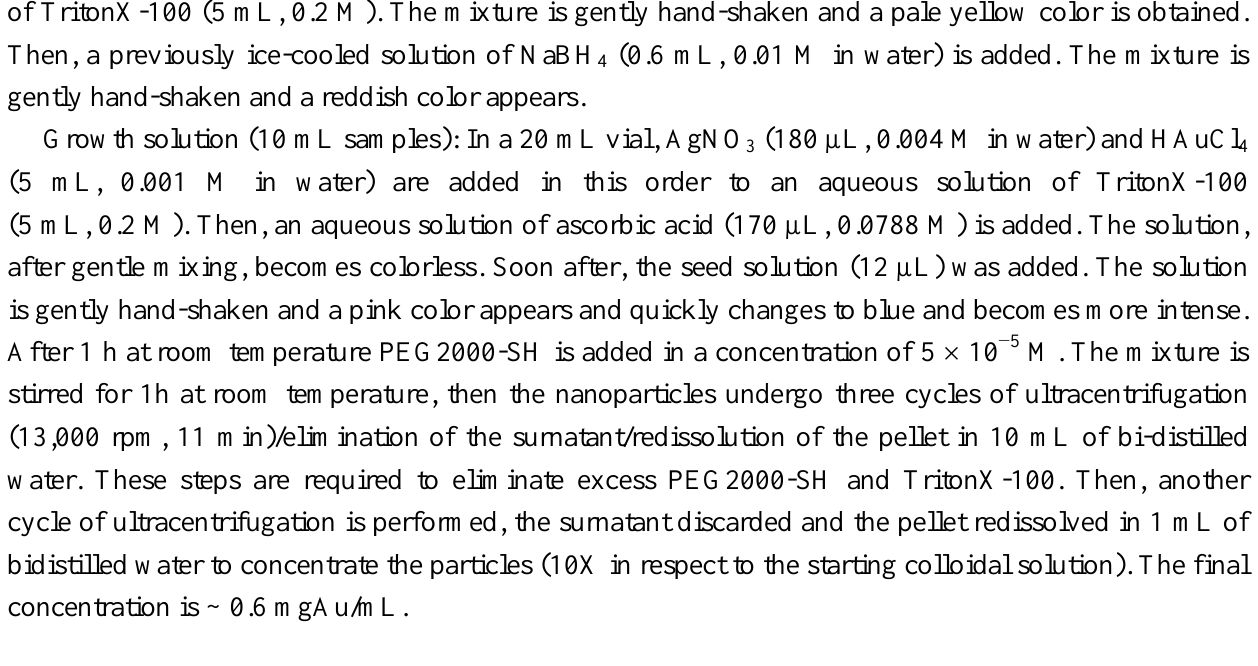
Figure 1. ( a ) UV-Vis-nIR absorption spectrum of the five-branched GNS. ( b ) TEM image of the same